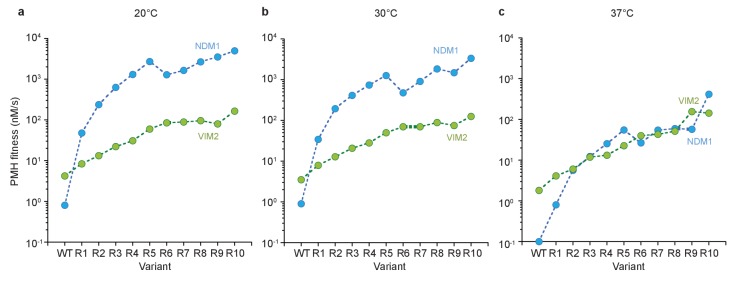
Effect of expression temperature on cell lysate PMH fitness (cell lysate activity in nM/s).Variants of NDM1 (blue) and VIM2 (green) were expressed at (A) 20°C, (B) 30°C, and (C) 37°C. Cell lysate preparation and PMH fitness measurement were performed identically for all expression temperatures.